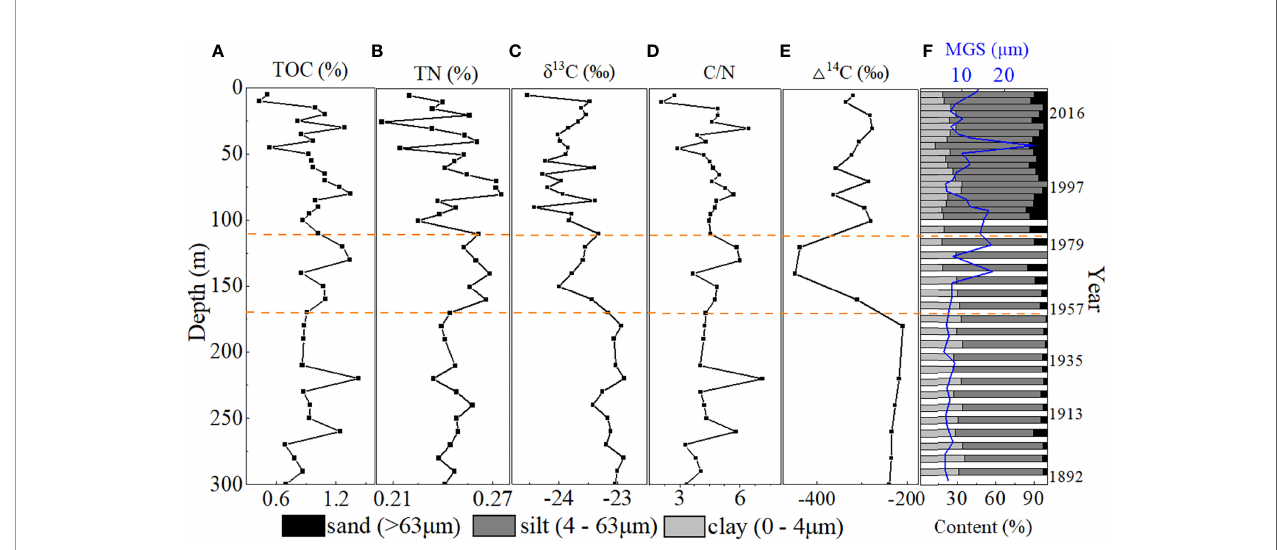
FIGURE 3 | Depth pro fi les of (A) TOC(%), (B) TN(%), (C) d 13 C( ‰ ), (D) C/N ratio, (E) D 14 C( ‰ ), and (F) median grain size (MGS) and mineral content (%).